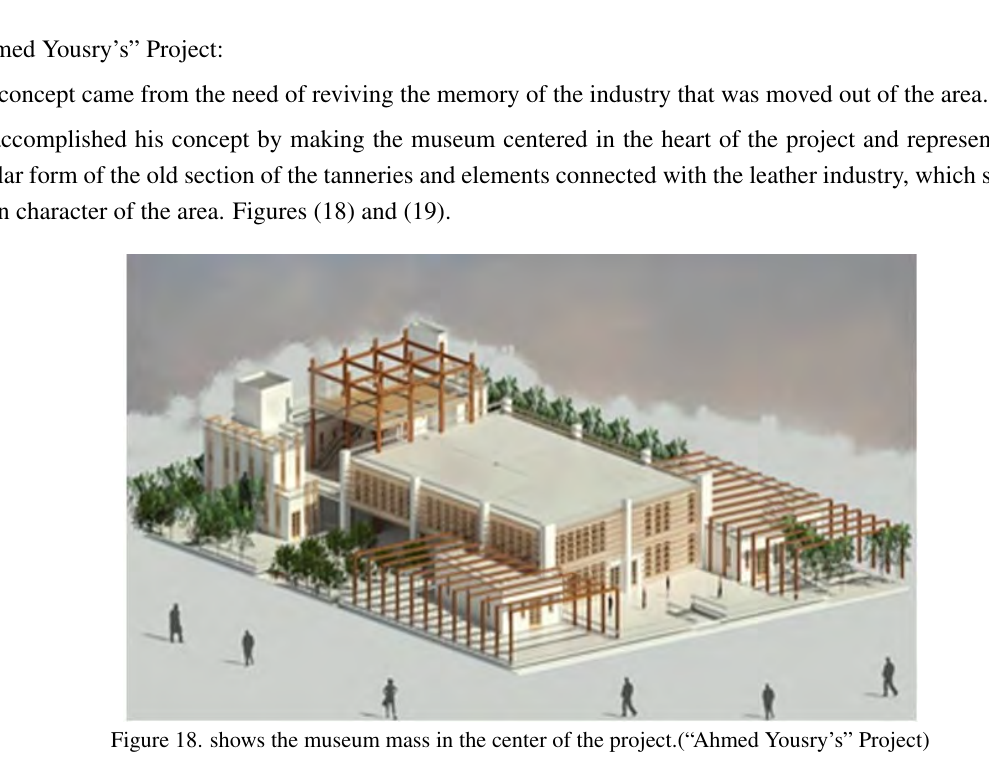
Figure 17. Elevation with wooden shades to reflect theurban character (“Amr Aly’s” Project)